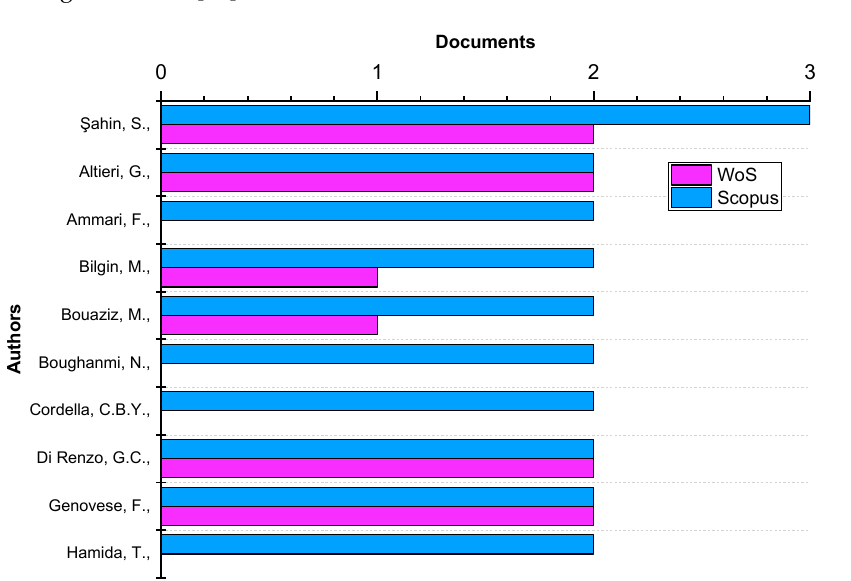
Figure 3. Publications trend of enrichment of VOs with plants antioxidants (based on data retrieved from Scopus and WoS databases).